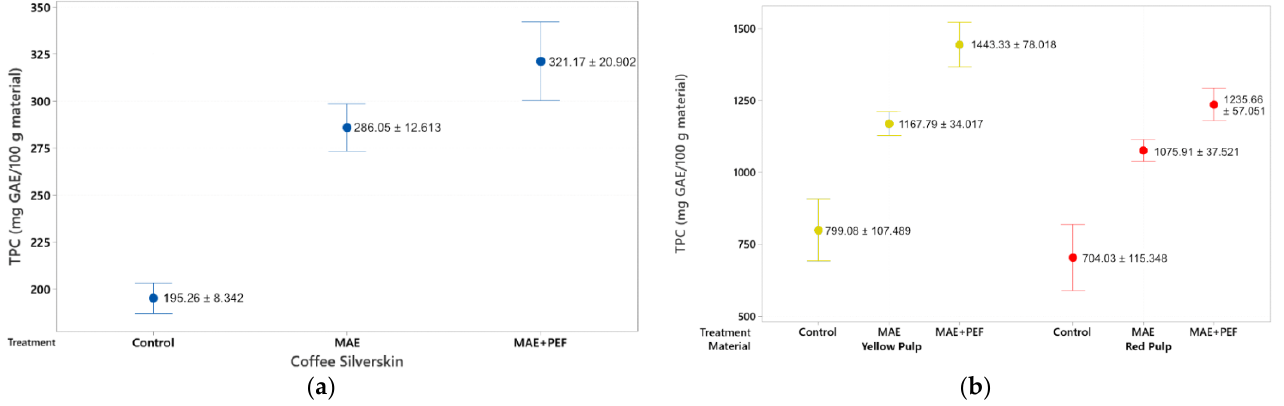
Figure 1. Total phenolic content of coffee agro-waste extracts. Values are represented as mean ± standard deviation ( n = 3). GAE: gallic acid equivalents. ( a ) Extraction results for parchment waste. ( b ) Extraction results for yellow and red pulp waste MAE: Microwave assisted extraction; PEF: Pulsed Electric Field pretreatment.